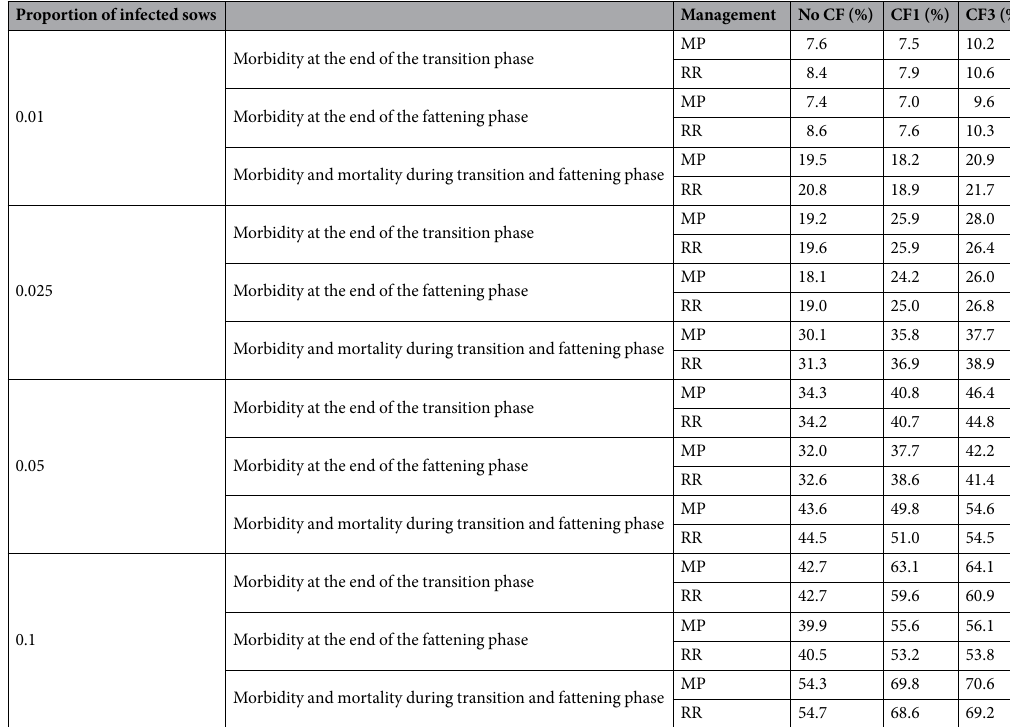
Table 1. Morbidity and mortality at the end of nursery and fattening period taking into account lactation (cross-fostering) and management procedures during the rearing period. Morbidity is calculated as the percentage of infected animals versus the whole population during one period and mortality is calculated as the percentage of dead animals versus the whole population during one period. CF means cross-fostering. CF1 and CF3 mean that cross-fostering is carried out one or three times during the lactation period. MP means orderly movements consisting of filling the pens during transition according to the sow’s origin and during fattening according to nursery distribution whereas RR means movements consisting of filling the nursery and fattening pens at random.